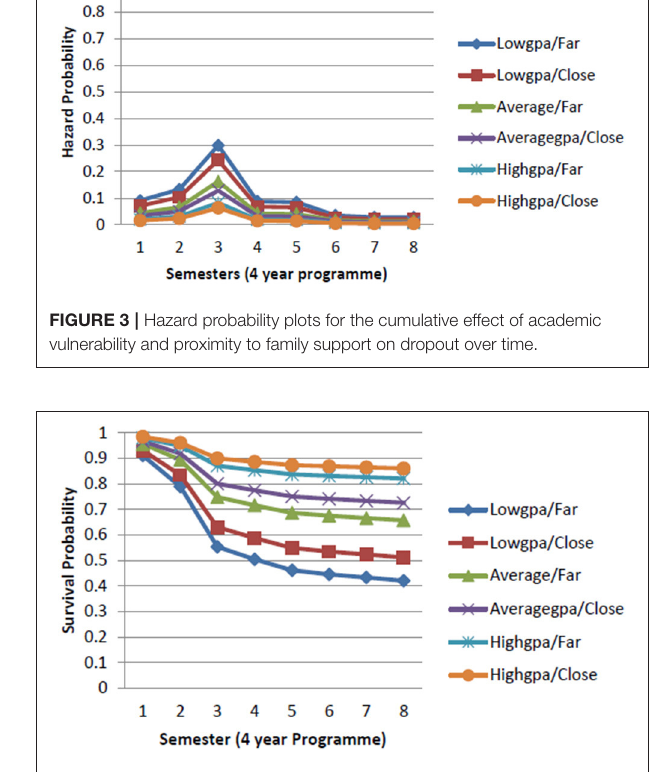
TABLE 4 | Effects of predictors on the trajectory of dropout. Predictors Est SE p-value h (OR) Gender (Female = 1) − 0.13 0.13 0.33 0.87 Entry GPA − 0.78 0.08 0.001 0.46 Distance from home (Close = 1) − 0.28 0.11 0.01 0.76